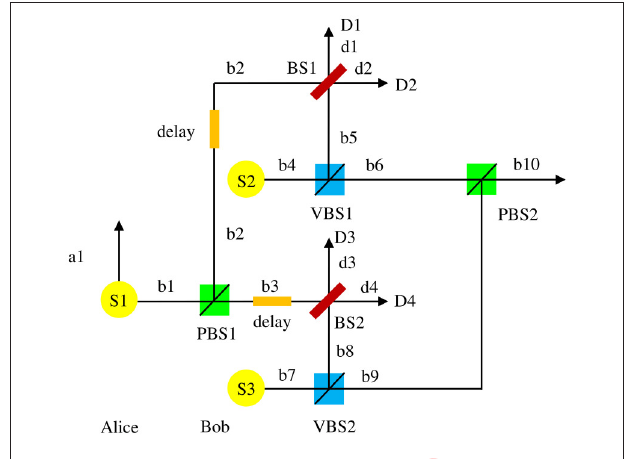
FIGURE 1 | A schematic drawing of our first ECP in linear optics. The ECP is constructed by the polarization beam splitter (PBS), variable beam splitter (VBS), and 50:50 beam splitter (BS). In the ECP, Alice and Bob share an arbitrary less-entangled single-photon spatial state. The single-photon qubit has the polarization feature of γ precisely control the time of the photon arriving at the